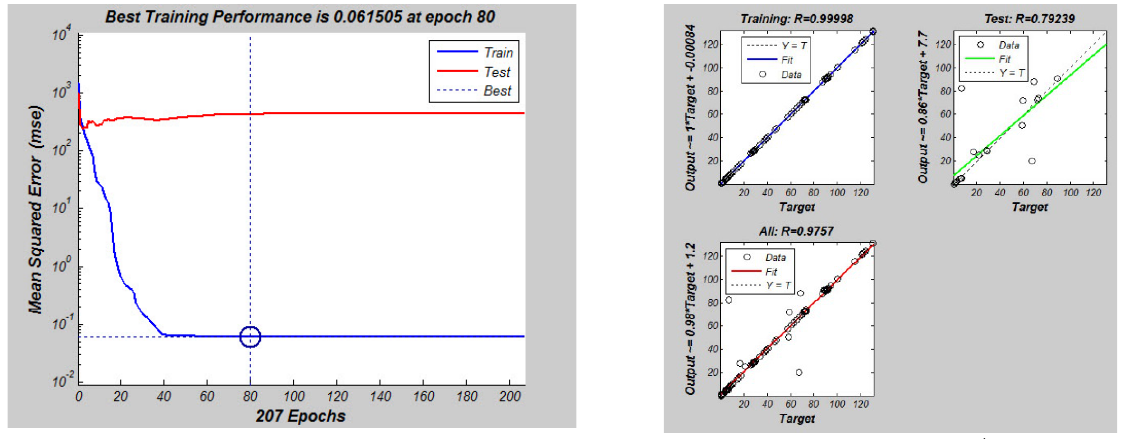
Fig. 3. Mean Square Error-Number of Epochs Fig. 4. Correlation Coefficient (Targets-Outputs)